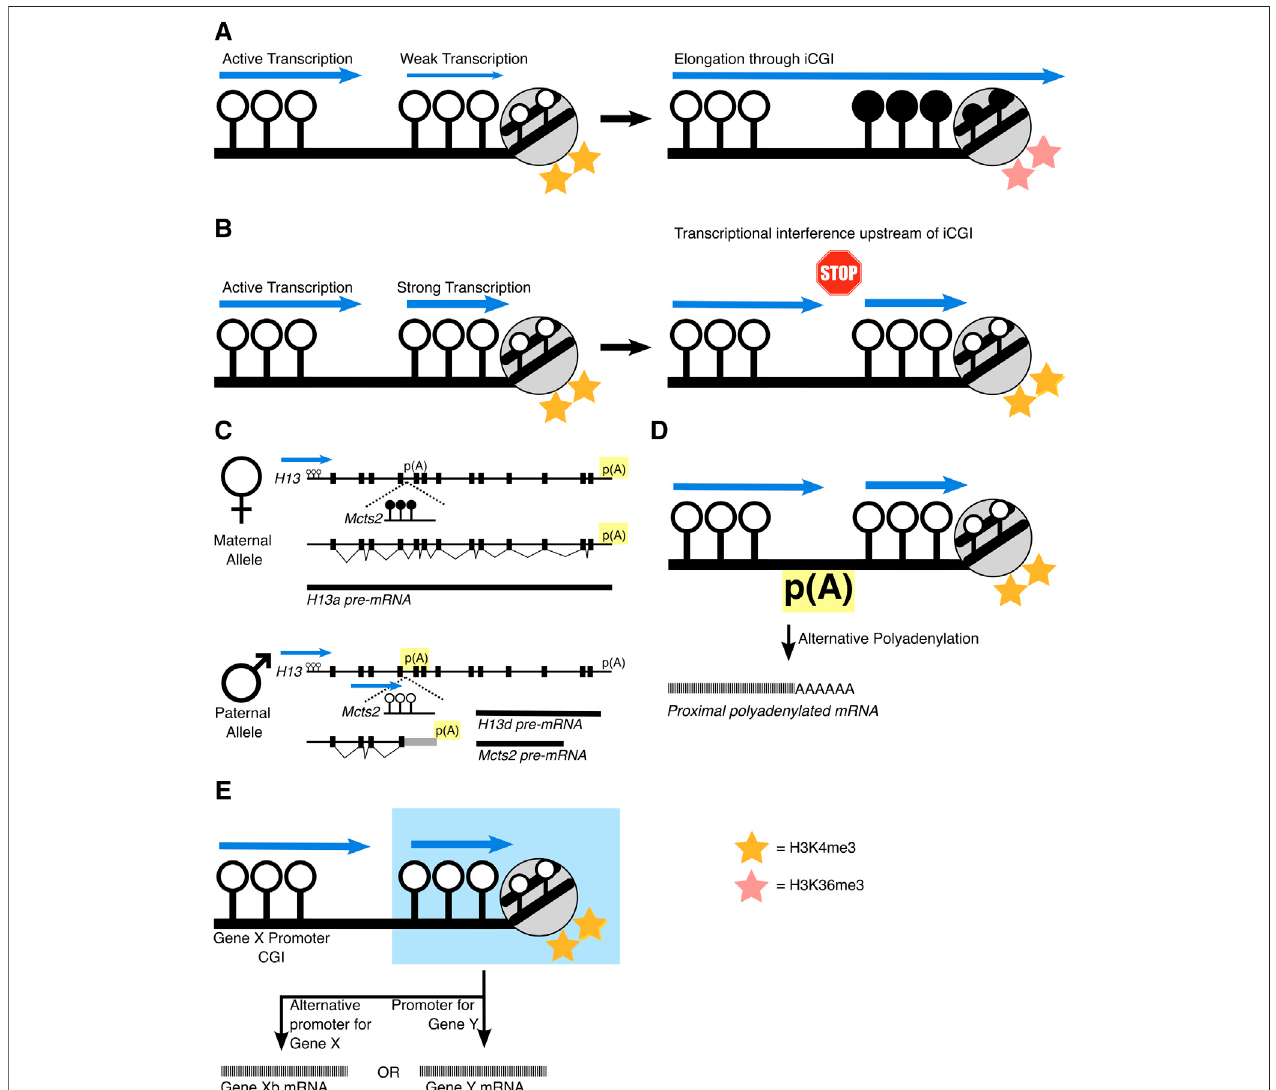
FIGURE2| Schematics ofhowiCGIs impact generegulationmechanisms. (A) Transcriptionthrougha ‘ weak ’ iCGI cansilence it,depositing H3K36me3 and DNA methylation at the iCGI. (B) However, if the iCGI exhibits strong transcriptional activity, it can lead to transcriptional interference. This can result in events akin to those at the (C) H13/Mcts2 locus, that exhibits allele-speci fi c PAS usage. Usage of the PAS is highlighted in yellow. (D) Similar mechanisms have been found other iCGIs. Alternatively, and insome cases, simultaneously, (E) the iCGI can act as apromoter itself, highlighted inblue, for either the host geneitself (gene X) or for adifferent ‘ nested ’ gene (gene